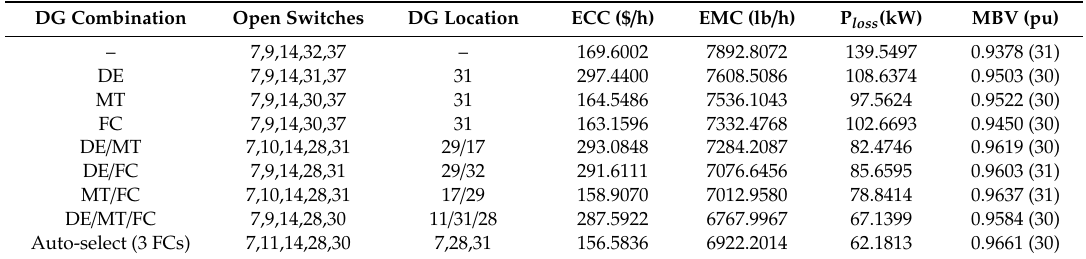
Table 5. Reconfiguration results for single DG and corresponding